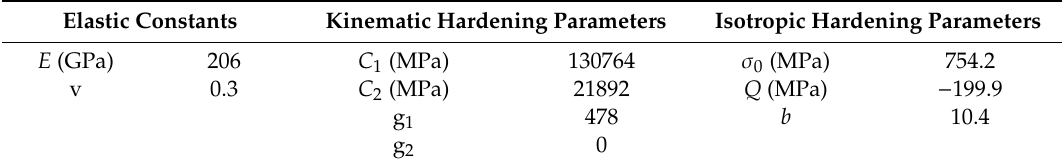
Table 3. Material parameters for J2 plasticity, including isotropic elastic constants and parameter for cyclic